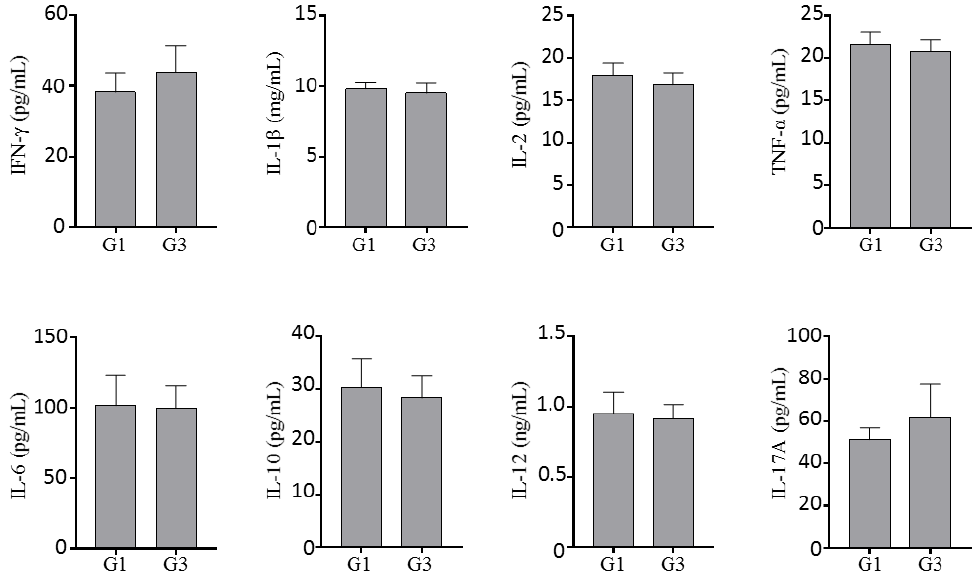
Figure 5. Effect of INO95 on the cytokine production in repeated dosed toxicity study. On day 91, mice were sacrificed, and serum cytokine levels were quantified and compared between INO95 treatment group and the non-treatment group. The data shown represent mean ± S.D. ( n = 5).